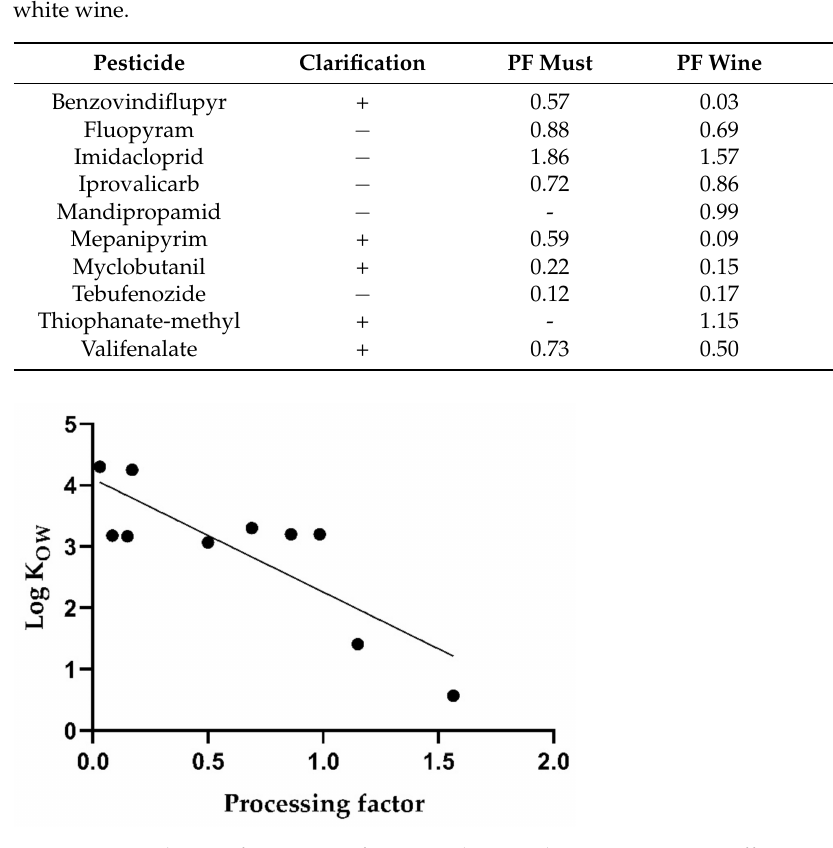
Figure 2. Correlation of processing factors with octanol-water partition coefficients of pesticide active substances for white wines. Each dot represents one of the pesticides in Table